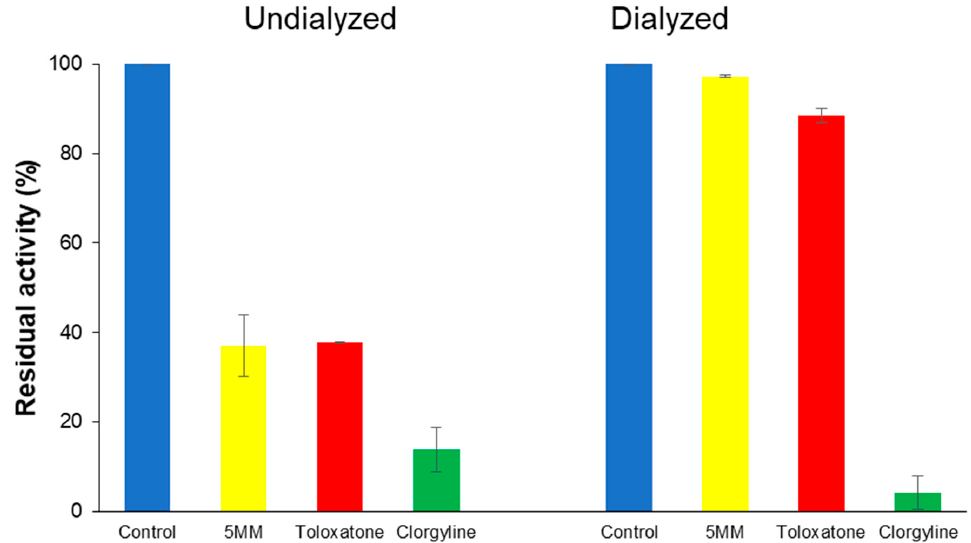
Figure 4. Inhibition of hMAO-A by 5MM and recovery of hMAO-A activity by dialysis. A concentration of ~2 × IC 50 was used as the inhibitor concentration. The data were presented as a result of duplicate experiments.